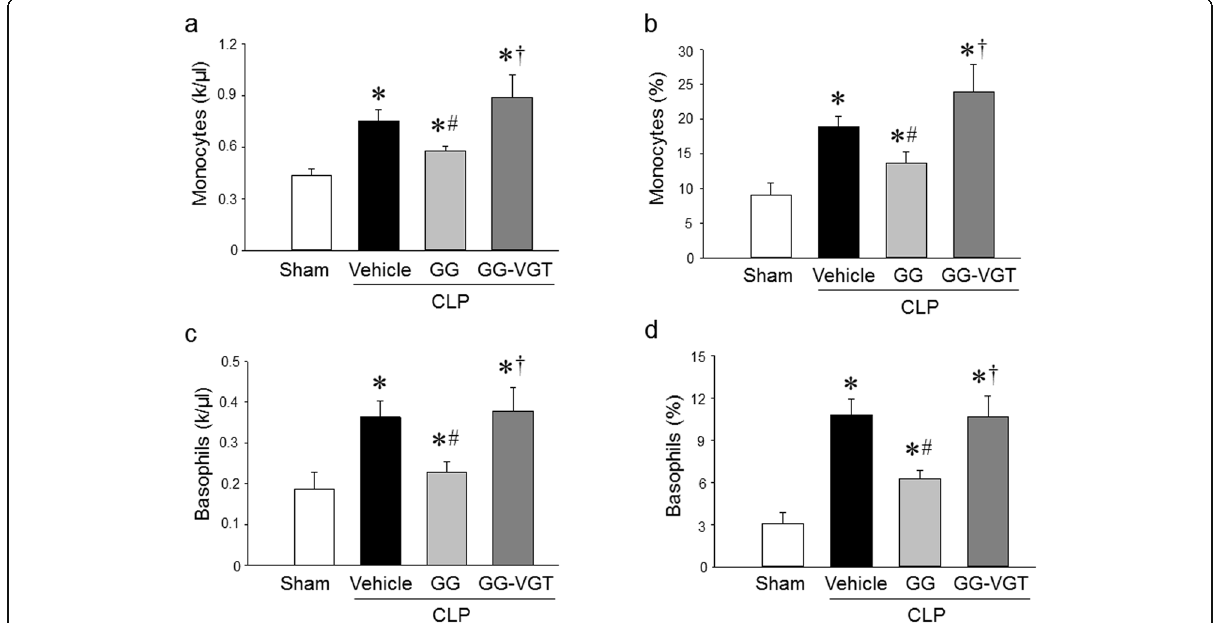
Fig. 4 Ghrelin and GH in combination correct the levels of circulating monocytes and basophils in aged rats with sepsis. Rats were subjected to sham or CLP operation and treated with vehicle (normal saline) or GG (ghrelin 80 nmol/kg, GH 50 μ g/kg) at 5 h after CLP. In an additional group of rats, vagotomy was performed at the time of CLP and treated with GG at 5 h after CLP. Blood was collected at 20 h after CLP. Circulating ( a, b ) monocytes and ( c, d ) basophils were measured using a hematology analyzer. Data are expressed as mean ± SEM ( n = 4 – 6 rats/group). * P < 0.05 vs. sham; # P < 0.05 vs. CLP with vehicle treatment; † P < 0.05 vs. CLP with GG